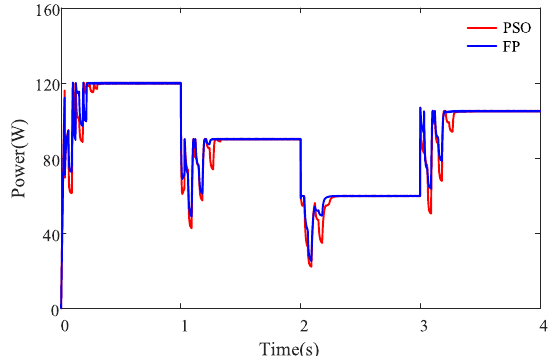
Fig. 7 Response of PSO and the proposed algorithm under